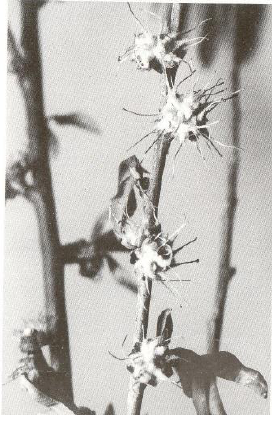
Figure 9. Peach chimera (bare flowers) Figure 10. With colored petals